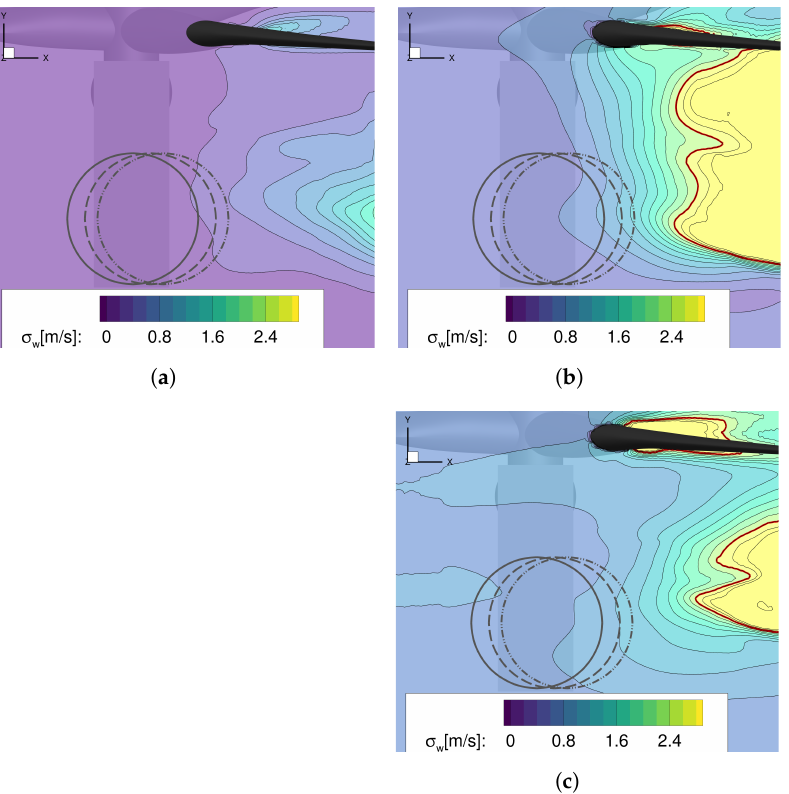
Figure 11. Standard deviation of the vertical velocity component σ w in a plane located at z CFD = 101m from [4]. The circles represent the integration area of Table 4 ( σ w0 —solid, σ w+1.5 —dashed, σ w+2.5 —dashed dotted) (OS-2). ( a ) C4 − V W = 11.3m/s; ( b ) C5 − V W = 25.0m/s; ( c ) C7 − V W =